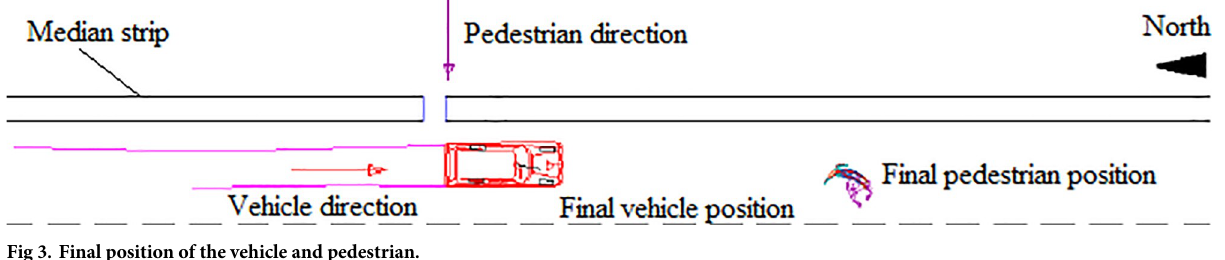
Fig 3. Final position of the vehicle and pedestrian.